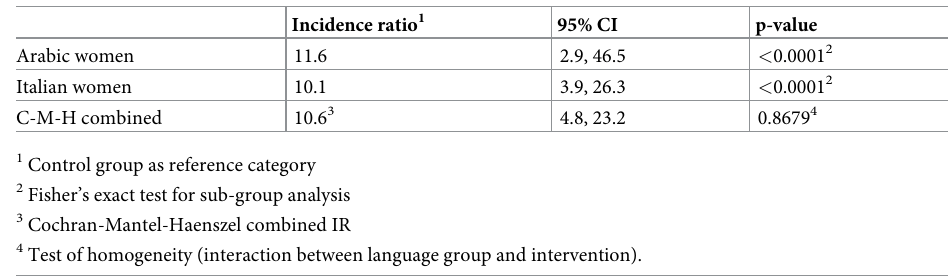
Table 6. Comparison of screening appointment booking rates according to language group in the phone call trial: Cochran-Mantel-Haenszel (CMH) test and sub-group